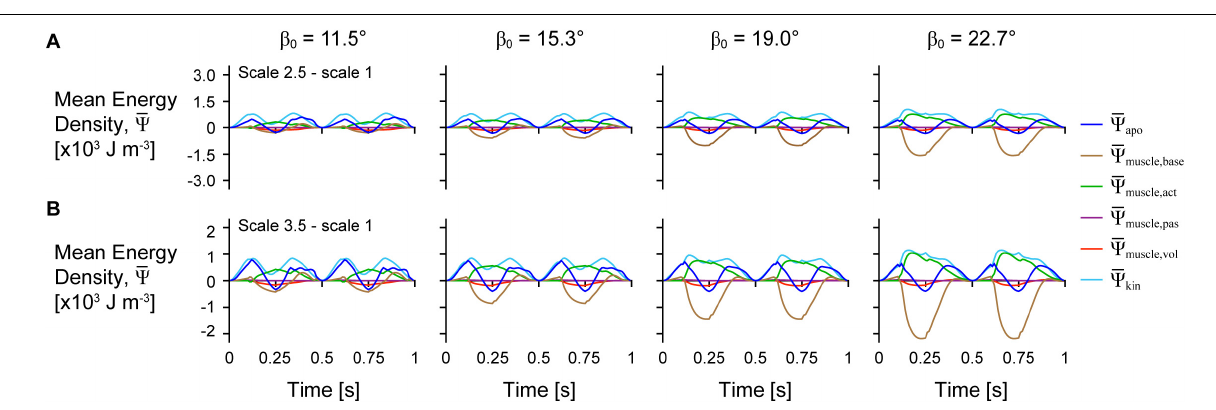
FIGURE 4 | Difference in tissue energy over time between scales and across initial pennation angles. Difference in mean energy-density ψ across tissue components between scale 2.5 and scale 1 (A) and scale 3.5 and scale 1 (B) simulations. Greater scale muscles are larger in size and have greater mass. All traces are for simulations with a strain of 5%, normalised excitation of 1, and initial pennation angles β 0 ranging from 11.5 to 22.7 ◦